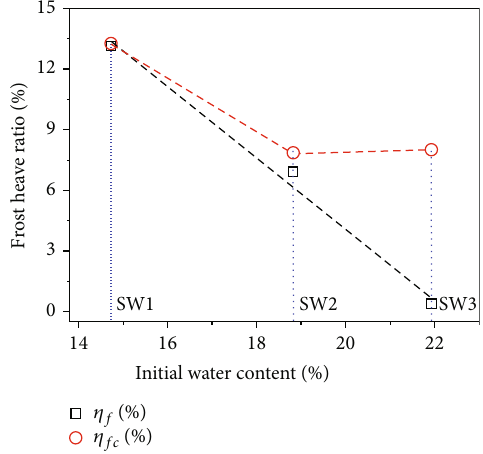
Figure 9: Variation of frost heave ratio with initial water content of samples.